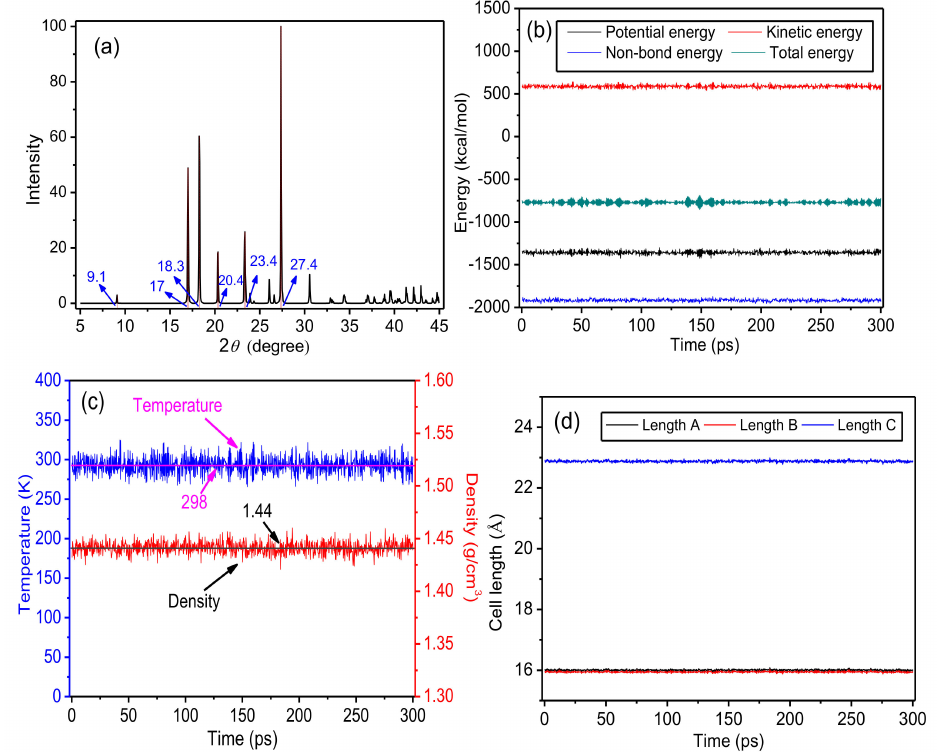
Figure 2. Parameters of the meta-aramid fiber crystal model. ( a ) X-ray diffraction (XRD) pattern of the supercell, ( b ) change of energy during the simulation (1 kcal/mol = 6.9477 × 10 − 21 J), ( c ) changes of temperature and density during the simulation, and ( d ) change of the unit cell length during the simulation (1 Å = 10 − 1